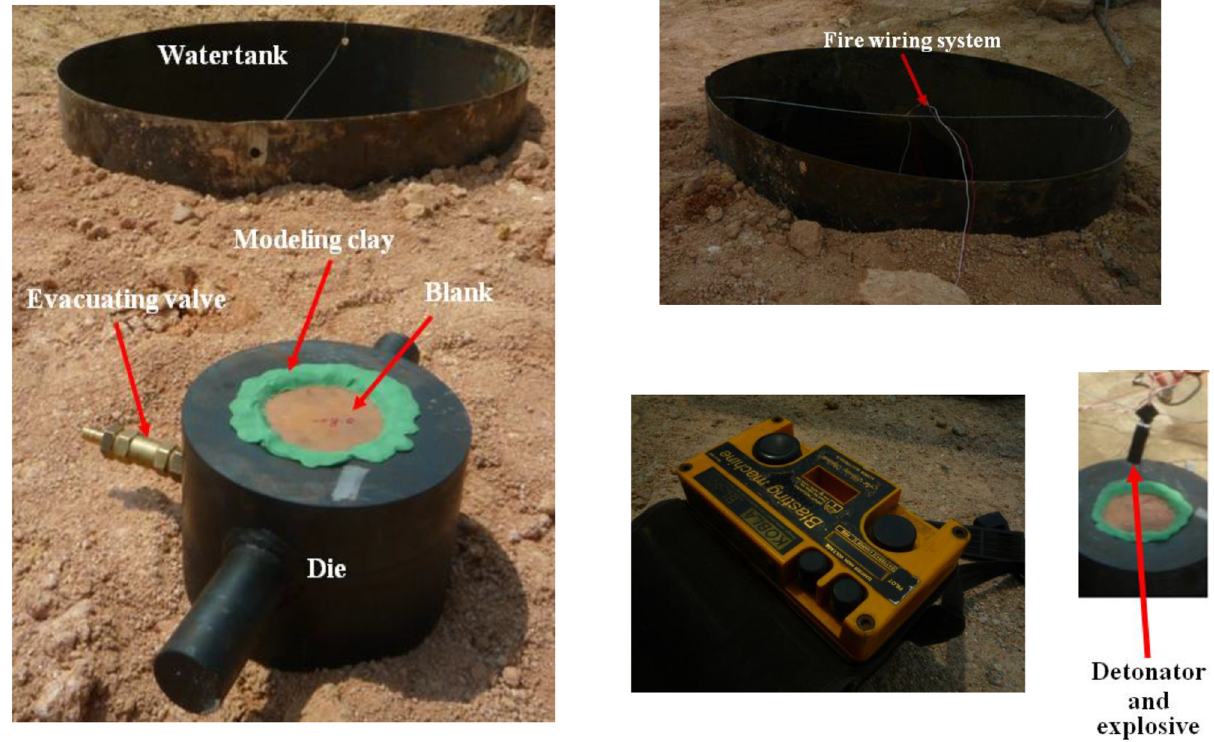
Fig. 4. Facilities of experiments.